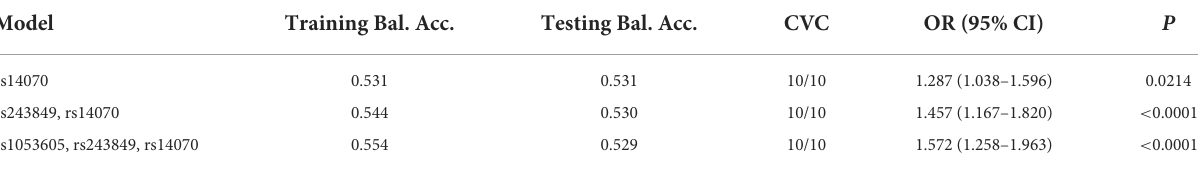
TABLE 6 MMP2 SNP–SNP interaction models analyzed by the MDR